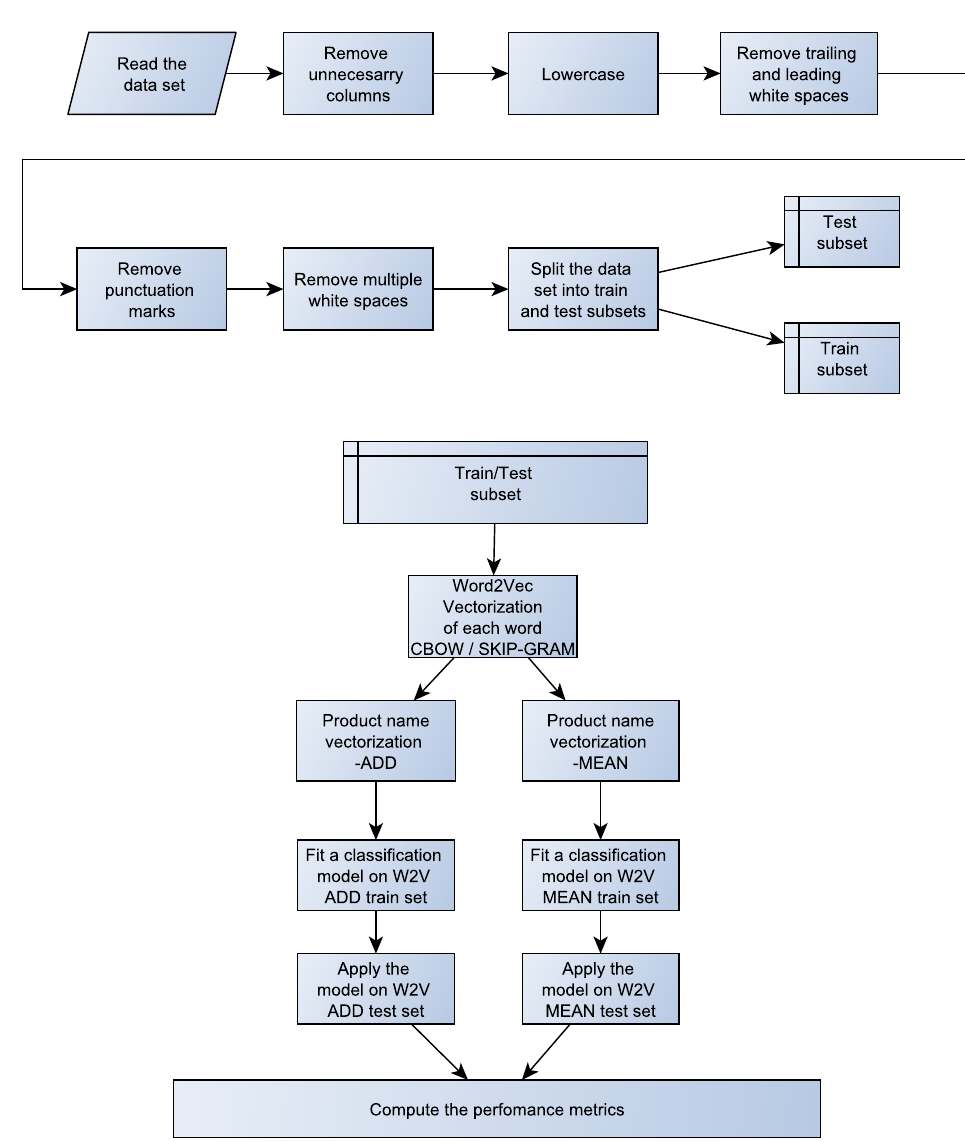
Figure 8. The classification process using Word2Vec embedding